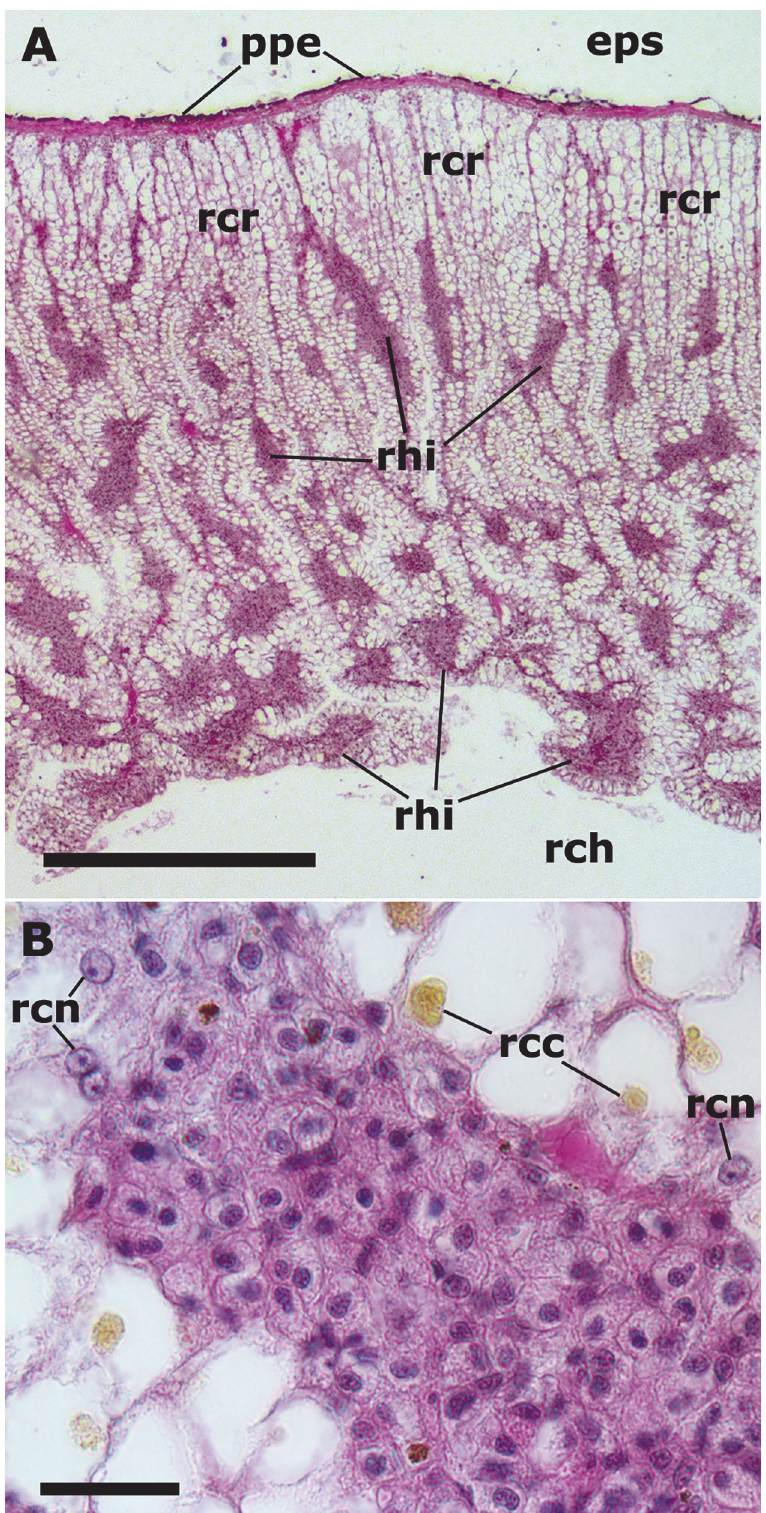
Fig 8. Renal hemocyte islets (HE-stain). (A) Kidney section perpendicular to the pallial surface of the organ. The mantle separates the kidney from the extrapallial space and is covered by the pigmented